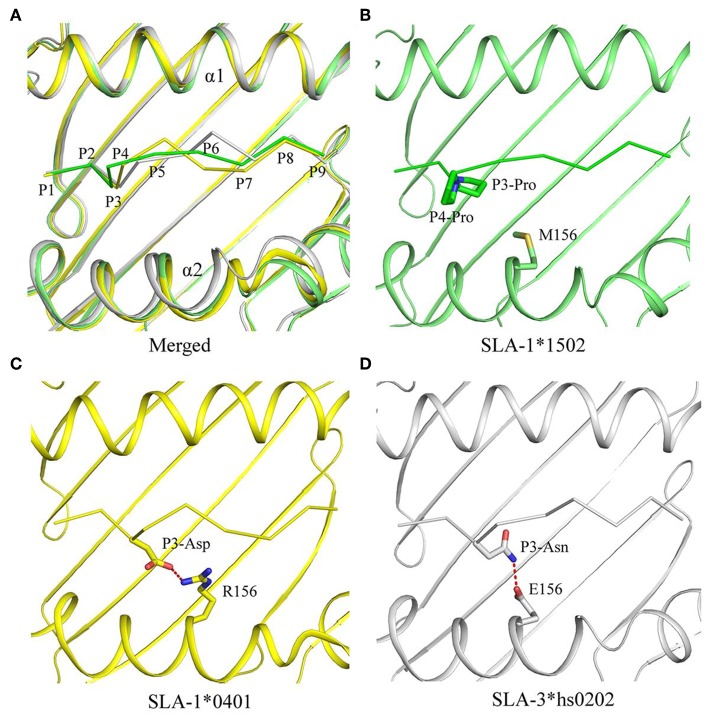
Comparison of NSP9-TMP9 and dissimilar peptide conformations and interactions among the three solved SLA I structures. The superposition of the structures of pSLA-1*1502 (green), p/SLA-1*0401 (yellow), and p/SLA-3*hs0202 (white). (A) The peptide conformations in these three structures are different. (B–D) Interactions between residue 156 and non-apeptide in the three p/SLA complexes. The salt bridge between the peptide and SLA I is represented by red dashes.